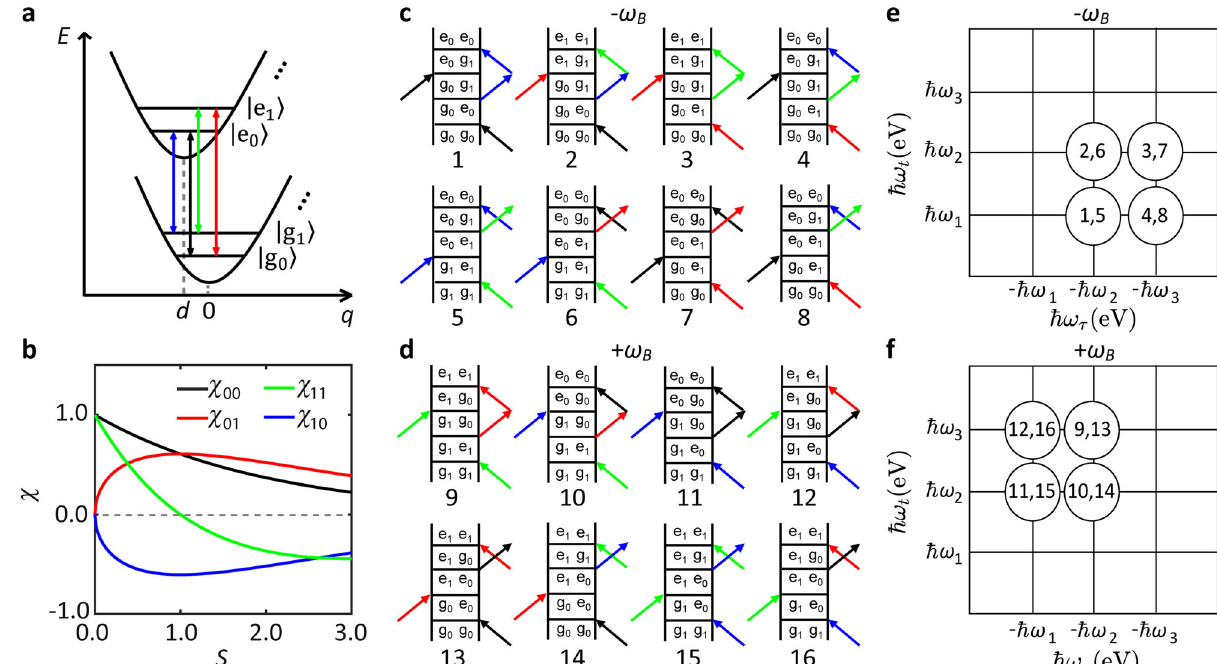
Fig. 3 Analysis of beating signals. a Schematic diagram of displaced harmonic oscillators (Franck – Condon coupling model 56 ) with two vibrational levels (cid:1) (cid:1) (cid:3) (cid:3) (cid:1) (cid:1) ( g 0 , g 1 ) in the electronic ground state, and two in the electronic excited state ( e 0 characterizes the EXPC strength. Transitions g 0 b Dependencies of Franck – Condon amplitudes χ ij ( i , j = 0 or 1) on S , which scales, d 2 /2. c , d Feynman pathways giving rise to the beating signals with c negative beating frequency − ω B , and, d positive frequency + ω B . e Beating-map locations of numbered Feynman pathways from panel c . f Beating-map locations of numbered Feynman pathways from panel d